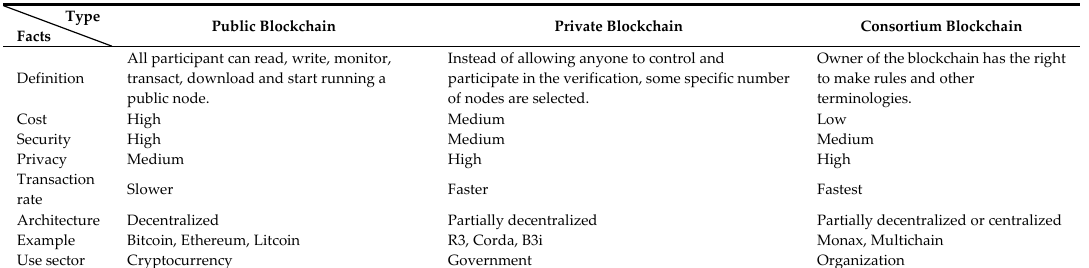
Table 2. Types of blockchain (public, private and consortiums).